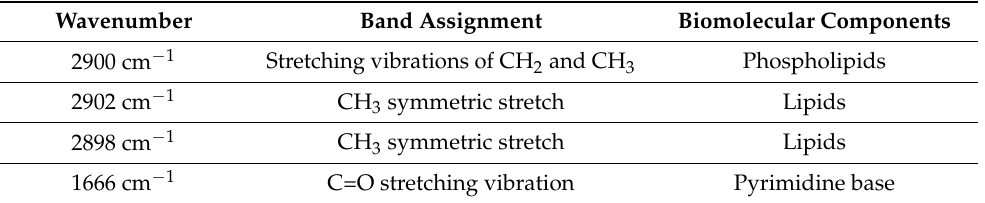
Table 3. Band assignment of SHAP value of each feature within the SVM model to discriminate non-diabetic individuals and uncontrolled type 2 diabetic patients and its molecular